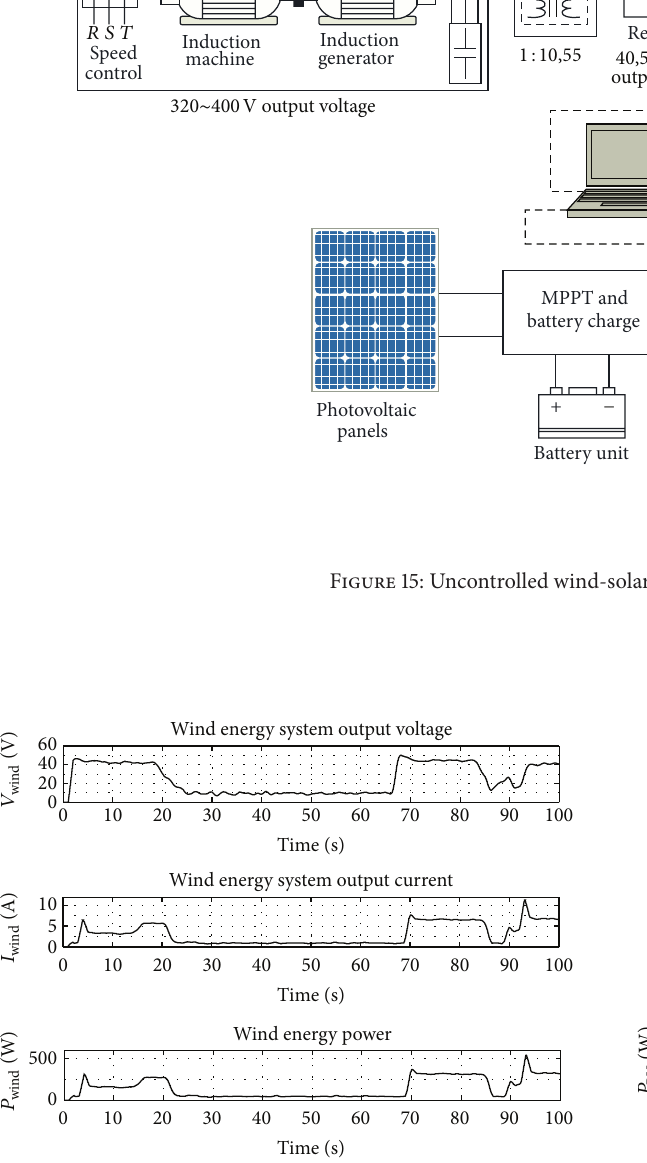
The changes of current, voltage, and power from the utility grid are given in Figure 22. The grid transfers energy to the loads during the time interval of 𝑡 = 45 – 68 s. Current, voltage and power changes on the load terminals can be seen in Figure 23. The load amount changes constantly.